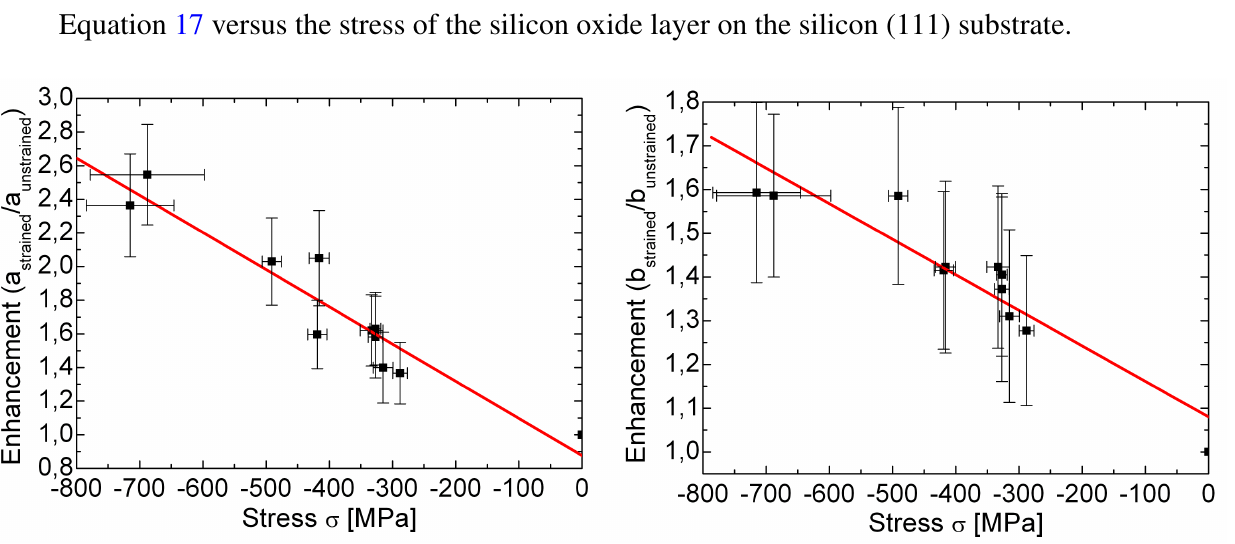
( a ) and c ( b ) of the azimuthal SH susceptibility in pp pp